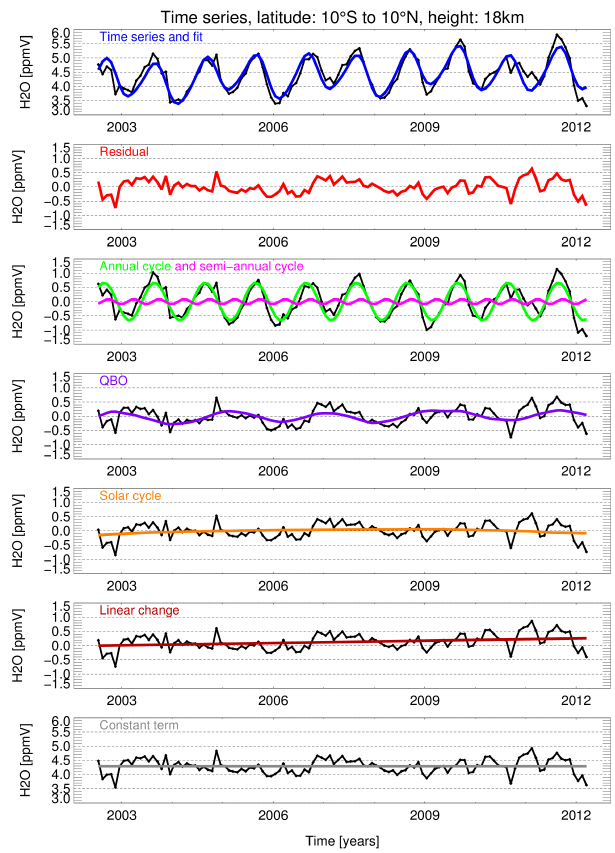
Figure 9. Monthly mean zonal mean water vapour volume mixing ratio time series from SCIAMACHY for 10 ◦ S–10 ◦ N and 18km height. The black line in the top panel shows the SCIAMACHY time series. The coloured lines in the lower panels show the different fit parameter terms, the red line in the second panel the residual. In the lower panels the black curves show the fit parameter terms shown in the corresponding panel plus the residual shown in the second panel.